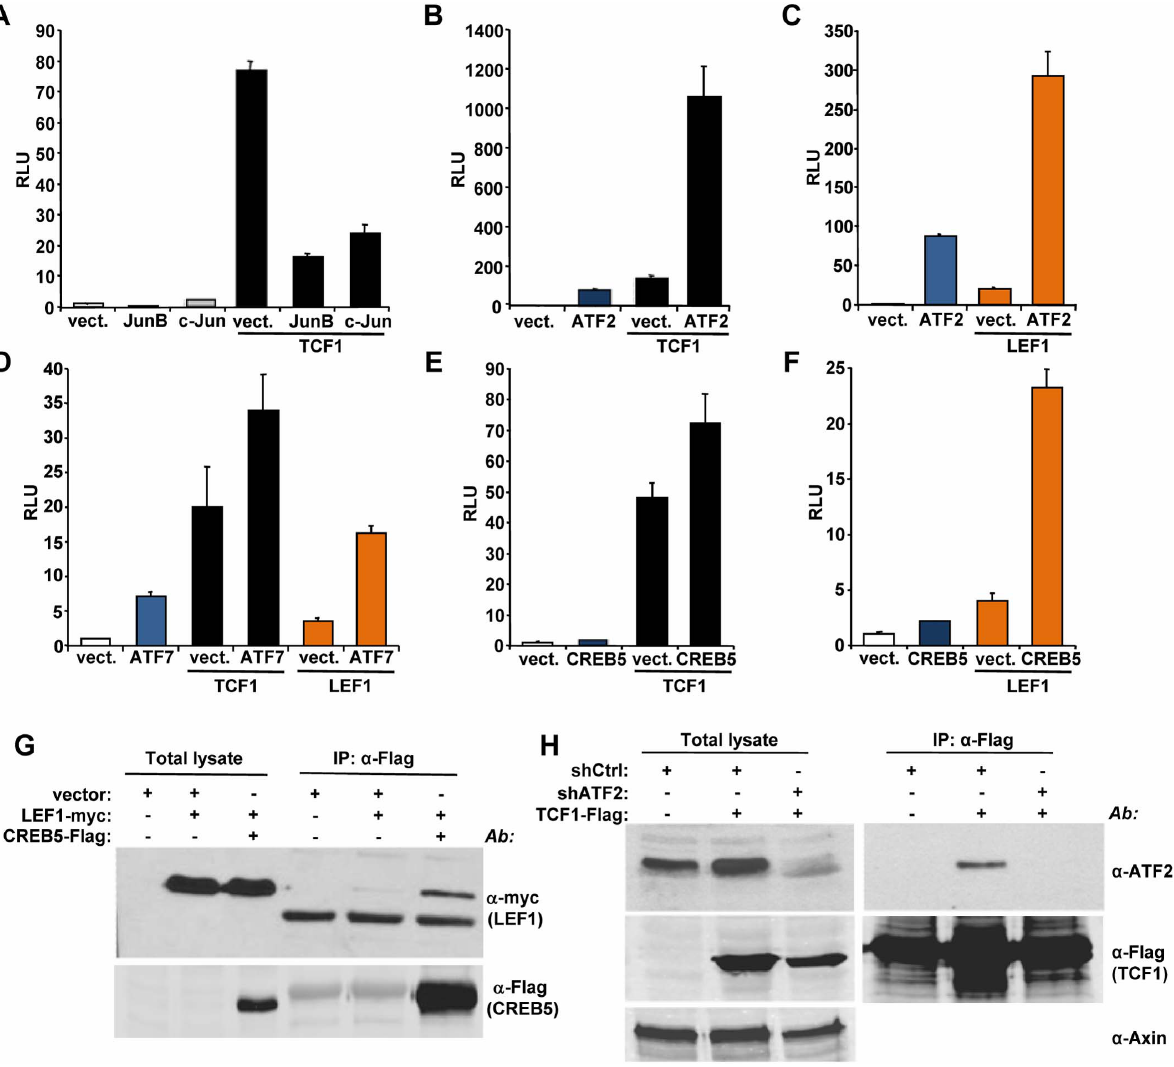
Figure 5. ATF2 transcription factors cooperate with TCF1/LEF1 to stimulate TCF/LEF activity. (A–F) 293T cells were co-transfected with the Supertop reporter, the renilla plasmid and the indicated TCF/LEF or AP1 transcription factors, followed by TCF/LEF reporter assay two days after transfection. (A) c-Jun and JunB inhibition of TCF1-induced reporter activity. (B–C) ATF2 synergizes with TCF1 (B) and LEF1 (C) to increase TCF/LEF activity. (D) ATF7 enhances TCF1- and LEF1-induced reporter activity. (E–F) CREB5 cooperated with TCF1 (E) and LEF1 (F). (G) myc-tagged LEF1 co- immunoprecipitates with Flag-tagged CREB5 in 293T cells. (H) Endogenous ATF2 co-immunoprecipitates with Flag-tagged TCF1 in 293T cells. Cells transduced with lentiviral shATF2 were used as a negative control and immunoblot with anti-Axin antibody was used as loading control for the total lysate.